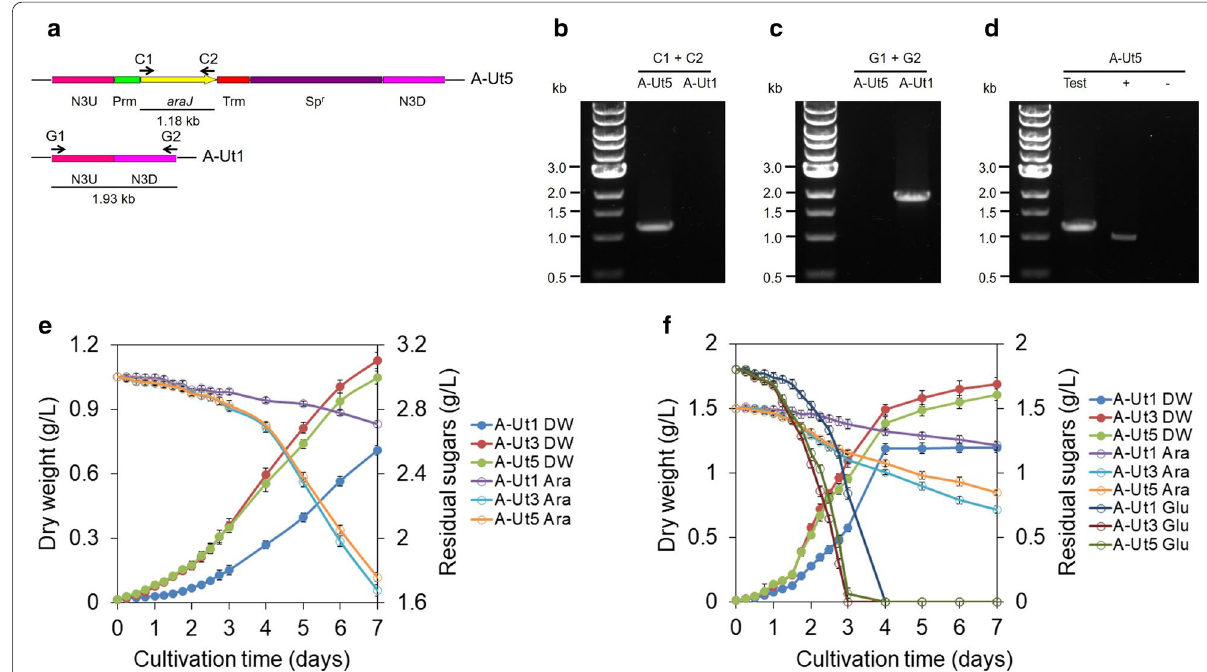
Fig. 6 Construction of A-Ut5 strain and comparison of growth and sugar consumption between A-Ut1, A-Ut3 and A-Ut5. a araJ was inserted into neutral site 3 under the control of psbA2 promoter (Prm) and 5ST1T2 terminator (Trm) in the A-Ut1 genome, using upstream (N3UP) and downstream (N3DW) regions for homologous recombination. The spectinomycin resistance cassette (Sp r ) was used for selection and segregation of the transformant. Numbered letters and arrows represent the primer pairs and the direction of the amplification, respectively. b The presence of araJ was verified with the help of primers C1-C2, which generated a ~1.18 kb band. A-Ut1 strain served as the negative control. c Chromosomal segregation was examined with the help of primers G1-G2. In the absence of uninterrupted neutral site 3, the primers failed to generate a PCR product, whereas the A-Ut1 strain included as the positive control produced a ~1.93 kb band. d Transcription of araJ was demonstrated with the help of primers C1-C2, represented as ‘Test’, where the product of ~1.18 kb was obtained. In the positive control ( ), petA -specific primers produced + a ~0.99 kb band from cDNA template. In the negative control (-), primers C1-C2 failed to amplify araJ from pure RNA sample. e A-Ut1, A-Ut3 and A-Ut5 were grown under mixotrophy in the presence of 20 mM (3.00 g/L) L-arabinose. Dry biomass and residual sugars were measured in the cultures grown in triplicate. (f) A-Ut1, A-Ut3 and A-Ut5 were grown under mixotrophy in the presence of 10 mM (1.50 g/L) L-arabinose and 10 mM (1.80 g/L) D-glucose. Dry biomass and residual sugars were measured in the cultures grown in